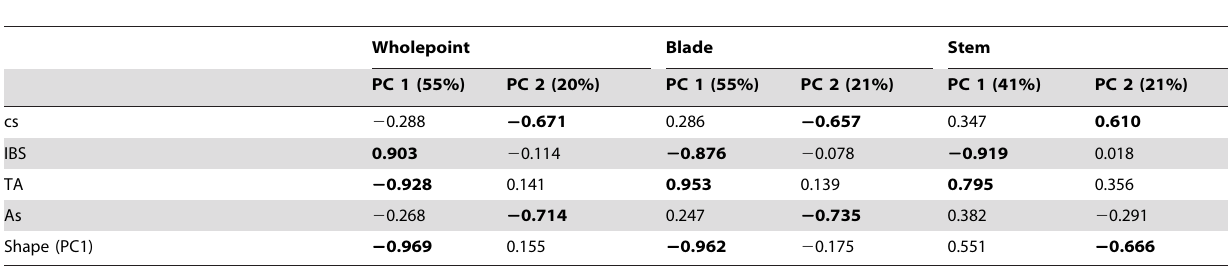
Table 1. Results concerning the composite PCA made after size, blade-stem length index (IBS), tip-angle, asymmetry, and shape of the whole projectile (left columns), blade (central columns), and stem (right